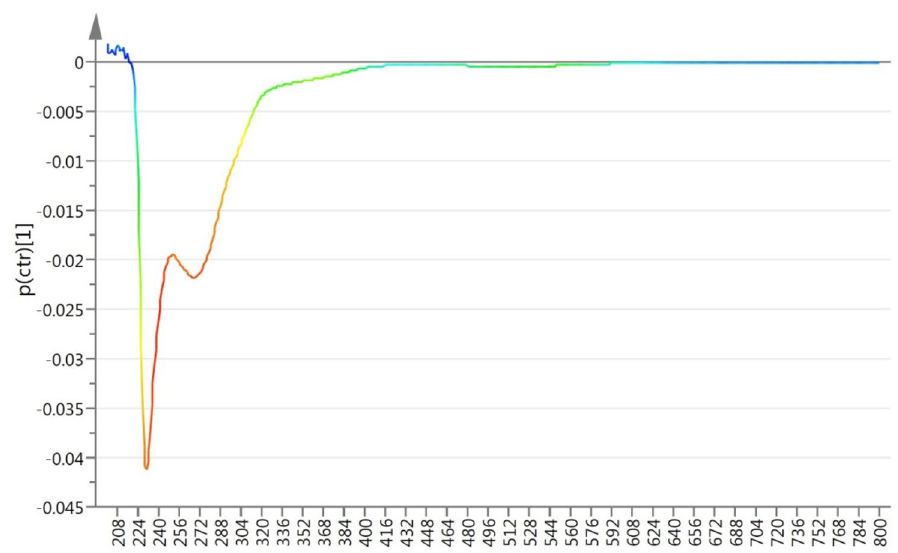
Figure 4. Coefficient plot derived from the OPLS-DA multivariate statistical analysis of UV–Vis spectra of pomegranate juices vs 30% v/v apple/pomegranate juice mixtures. The spectral variables responsible for the separation among the groups are represented in red. These are the regions of the spectra mostly affected by the